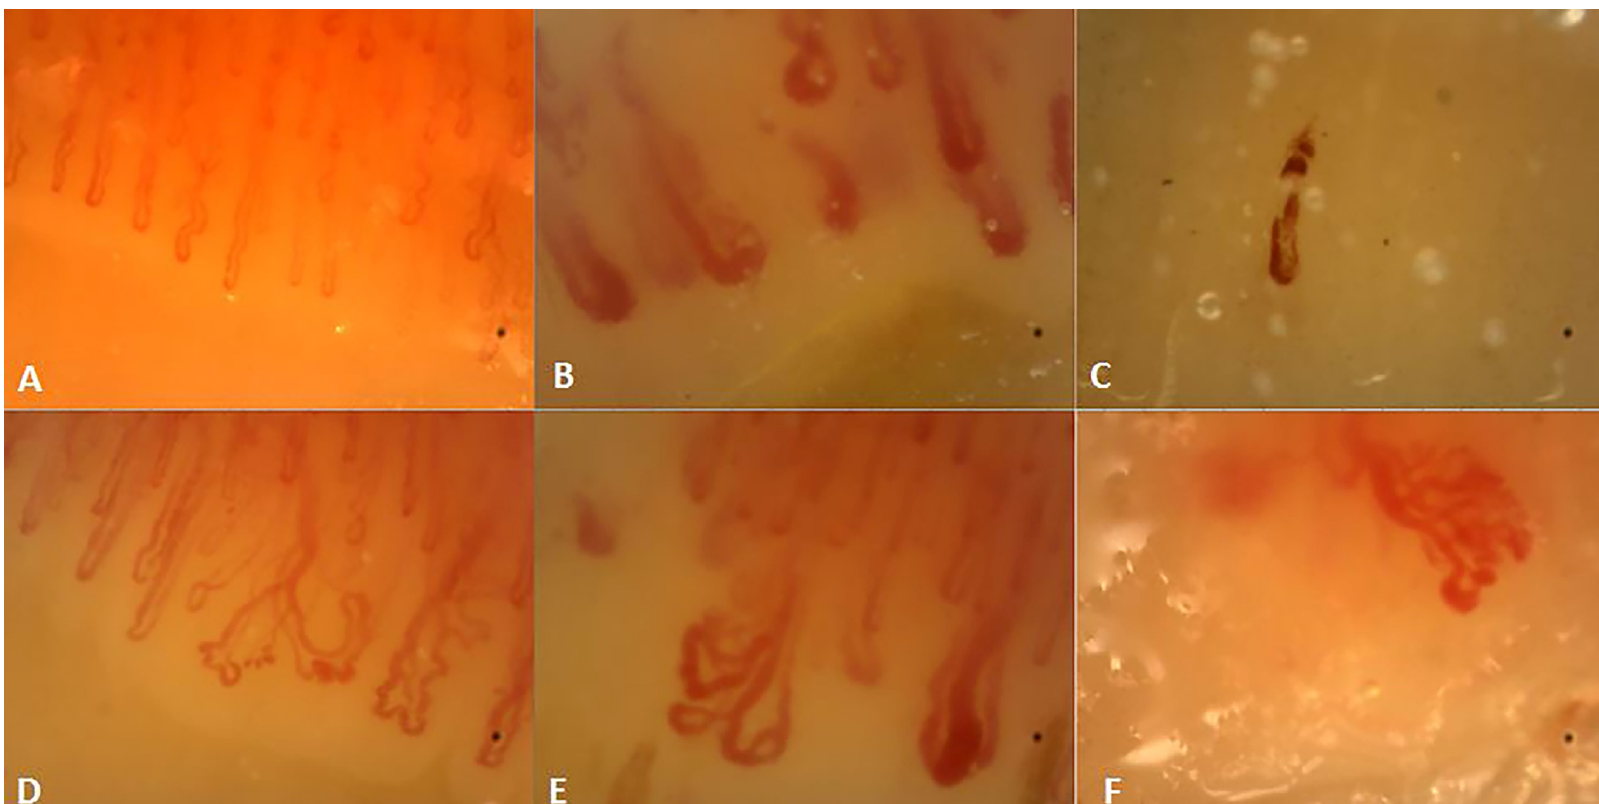
Figure 1. Description of Nailfold videocapillaroscopy. ( A ) Normal pattern, ( B ) presence of giant capillaries, ( C ) avascular area with single microhemorrhage and D – F : bushy capillaries.